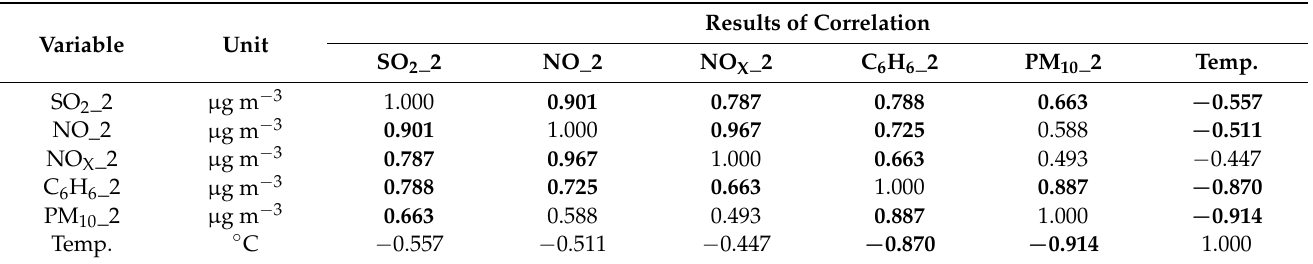
Table 5. Statistical values of selected indicators of air pollution and temperature in Bacau